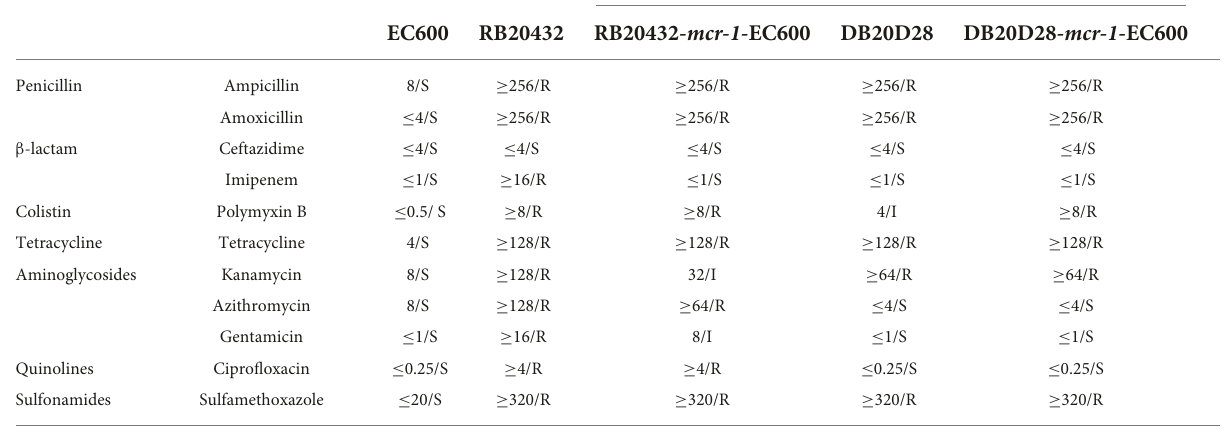
TABLE 1 The result of MIC by using VITEK-2.